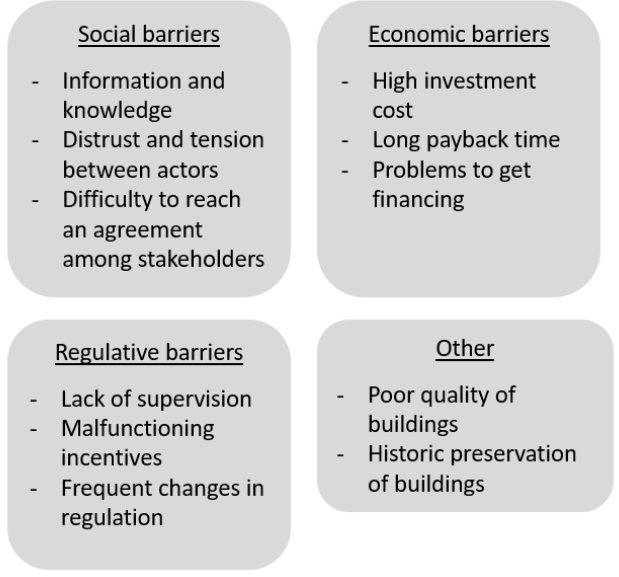
Figure 3 . Four categories of barriers presented in this study and the main barrier types found.